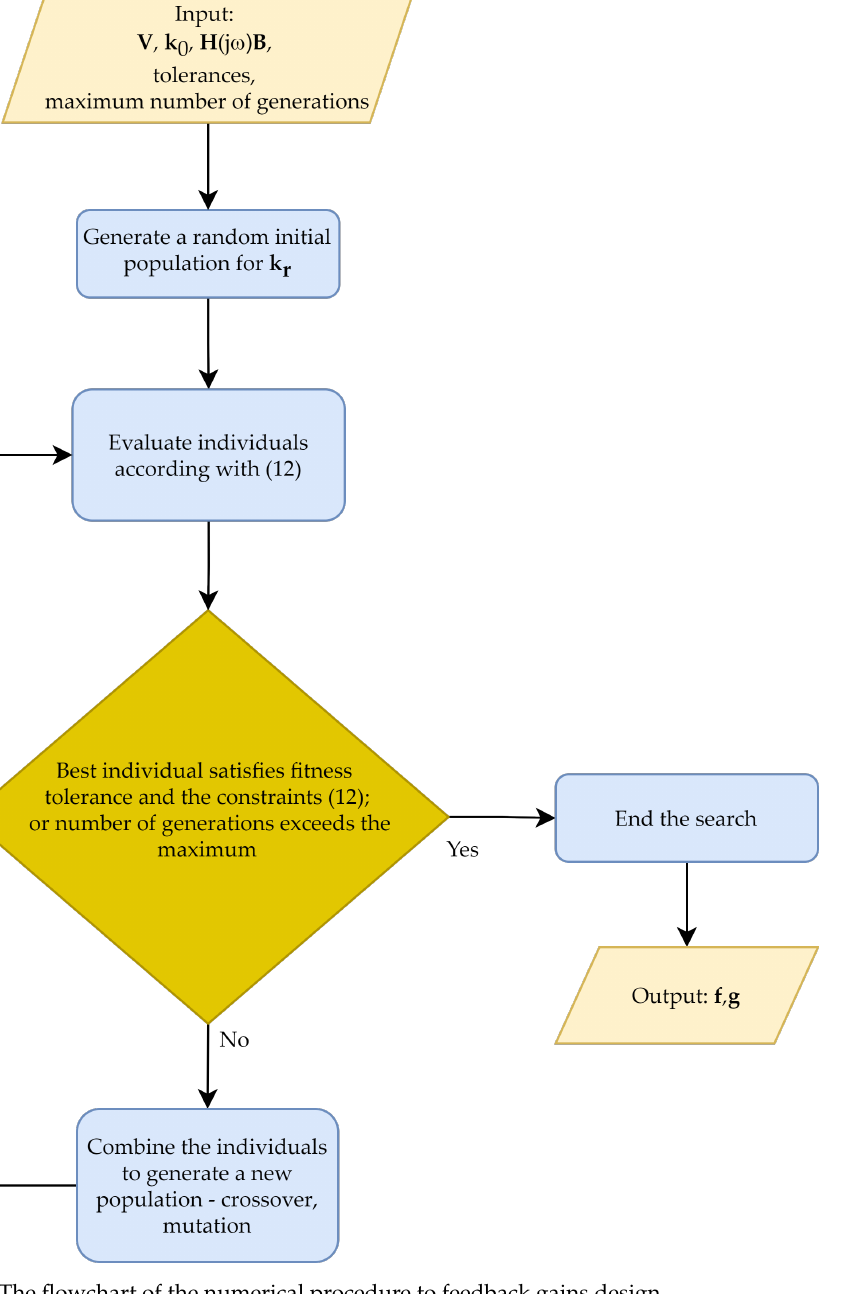
Figure 1. The flowchart of the numerical procedure to feedback gains